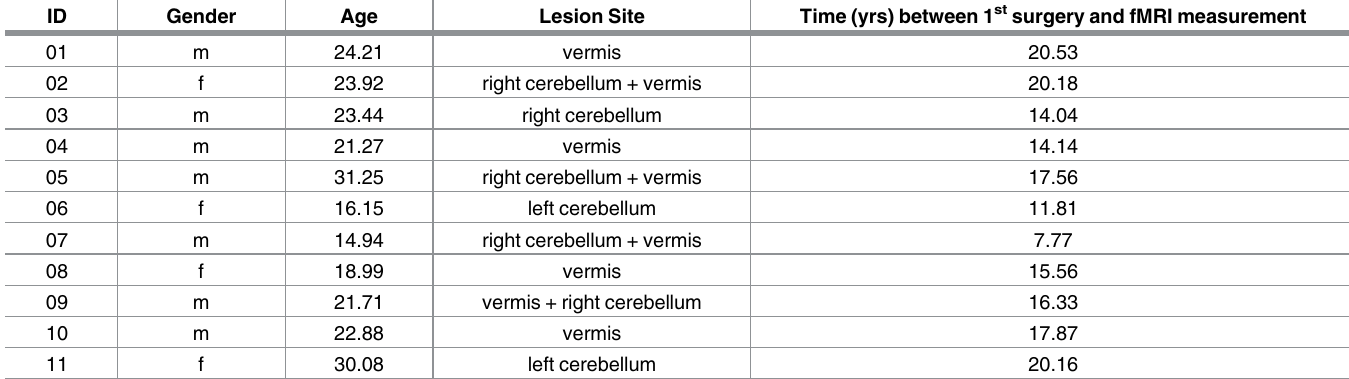
Table 1. Detailed description of patient sample including age, gender, lesion site, and time between surgery and